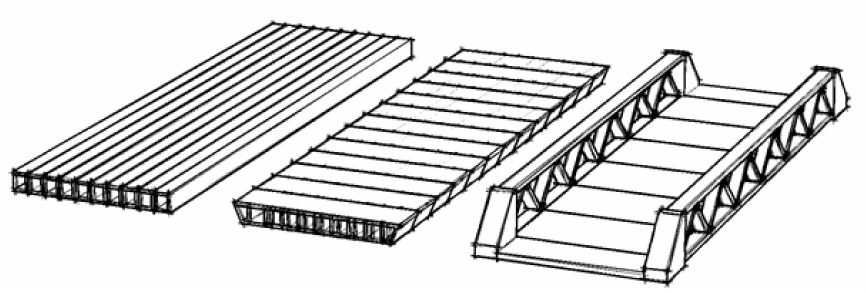
Figure 11. The three bridge types that are considered in the SMART bridge